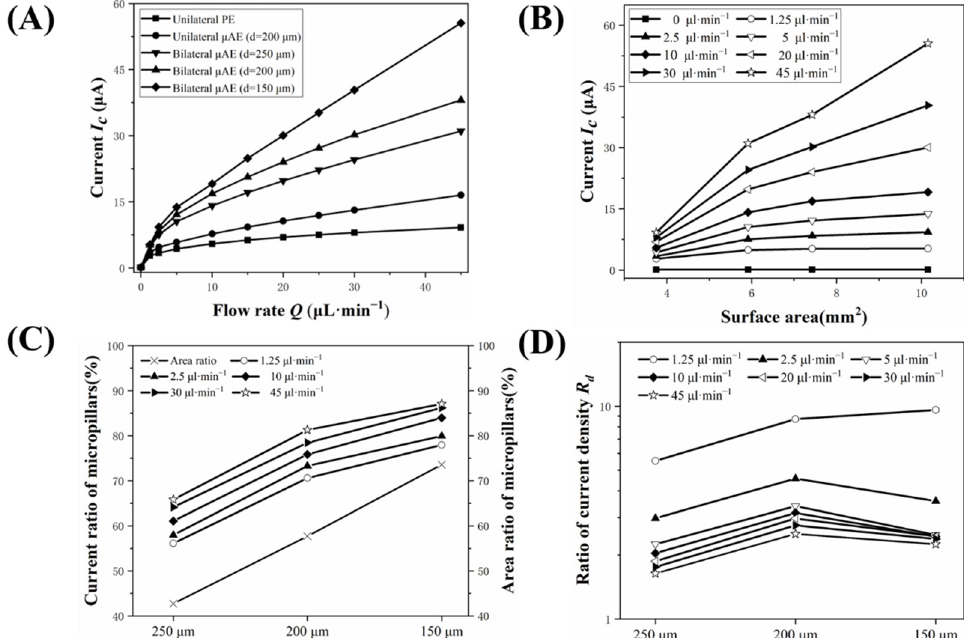
Figure 3. ( A ) Current responses of unilateral PE, unilateral µAE and bilateral µAEs with various spacings at different flow rates. ( B ) Current responses of PE, bilateral µAEs with various surface area at different flow rates. ( C ) Current and area ratios of bilateral µAEs with various spacings at different flow rates. ( D ) Ratios of the current density between the first and last row of micropillars.